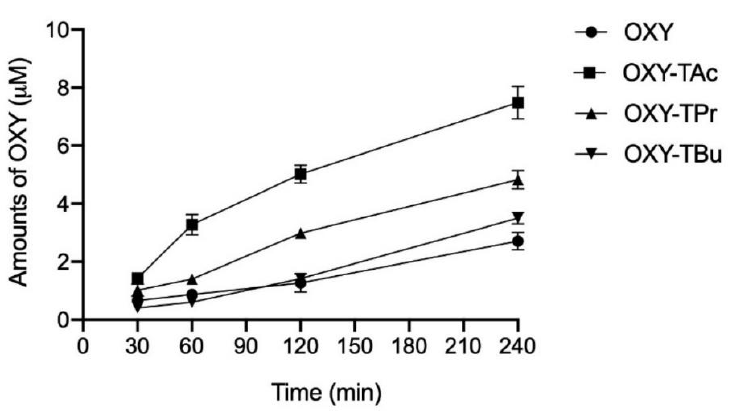
Figure 3. Time course of transport of OXY derived from OXY or OXY ester prodrugs across the Caco-2 cell monolayers. The concentration of each compound at selected timepoints in basolateral compartment was measured using HPLC. The data are expressed as the mean of four replicates ± SD.